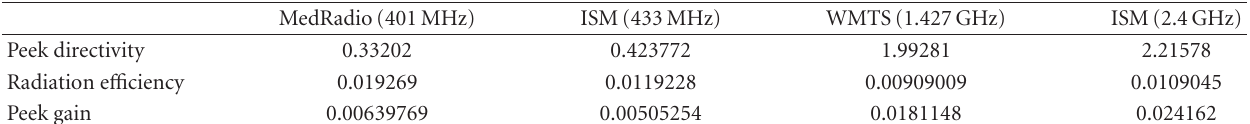
Table 2: The peek directivity, radiation e ffi ciency, and peek gain results of proposed antenna.